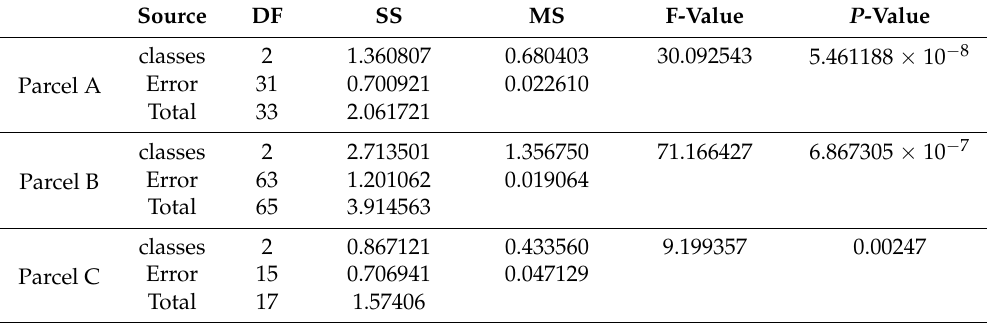
Table 4. Results of the ANOVA of UAV based NDVI vin map in relation to the three vigour classes from in-field